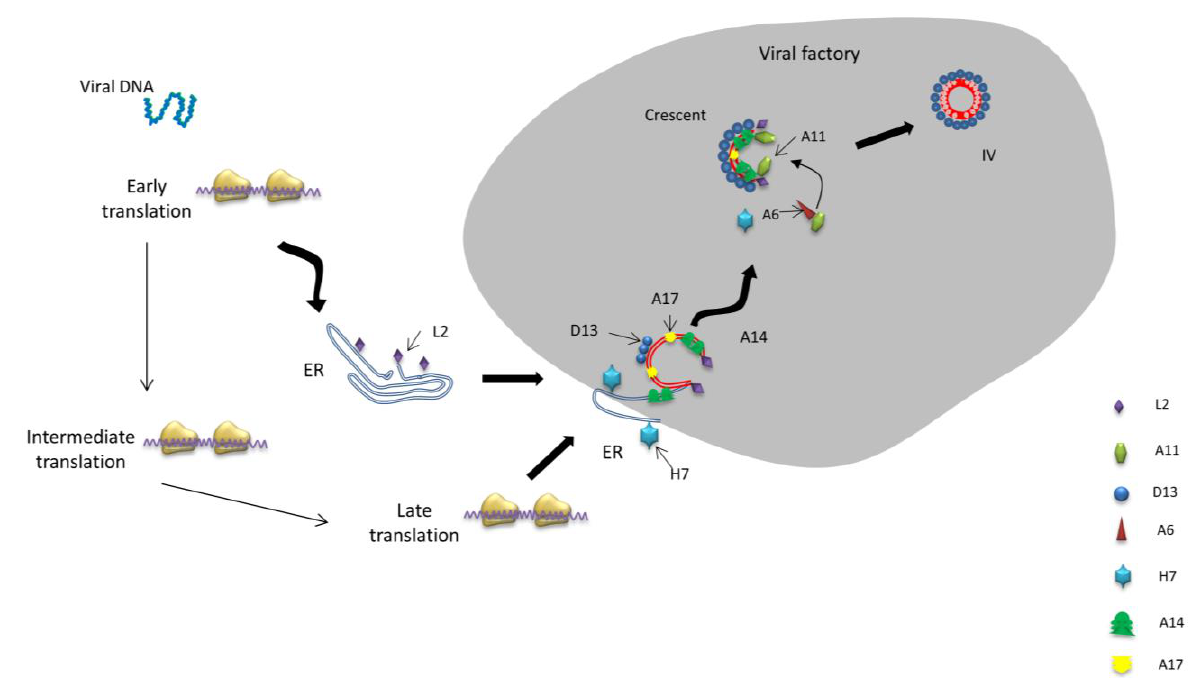
Figure 1. Model of Vaccinia virus (VACV) crescent membrane formation. Early transcribed protein L2 associates with the ER membrane and recruits it to viral factories, then L2 interacts with A30.5 or other unidentified proteins to rupture the ER membrane into small sections, while A14 and A17 are synthesized in the membrane in a co- translational fashion. Smooth membrane structures are recruited, opened up, and presented to pre-assembled scaffolds of D13, where D13 interacts with A17 to form crescent precursors. A11 stabilizes the end of the crescent to prevent it resealing, whereas A6 may play a role in transporting or controlling the transient association of A11 with the crescent